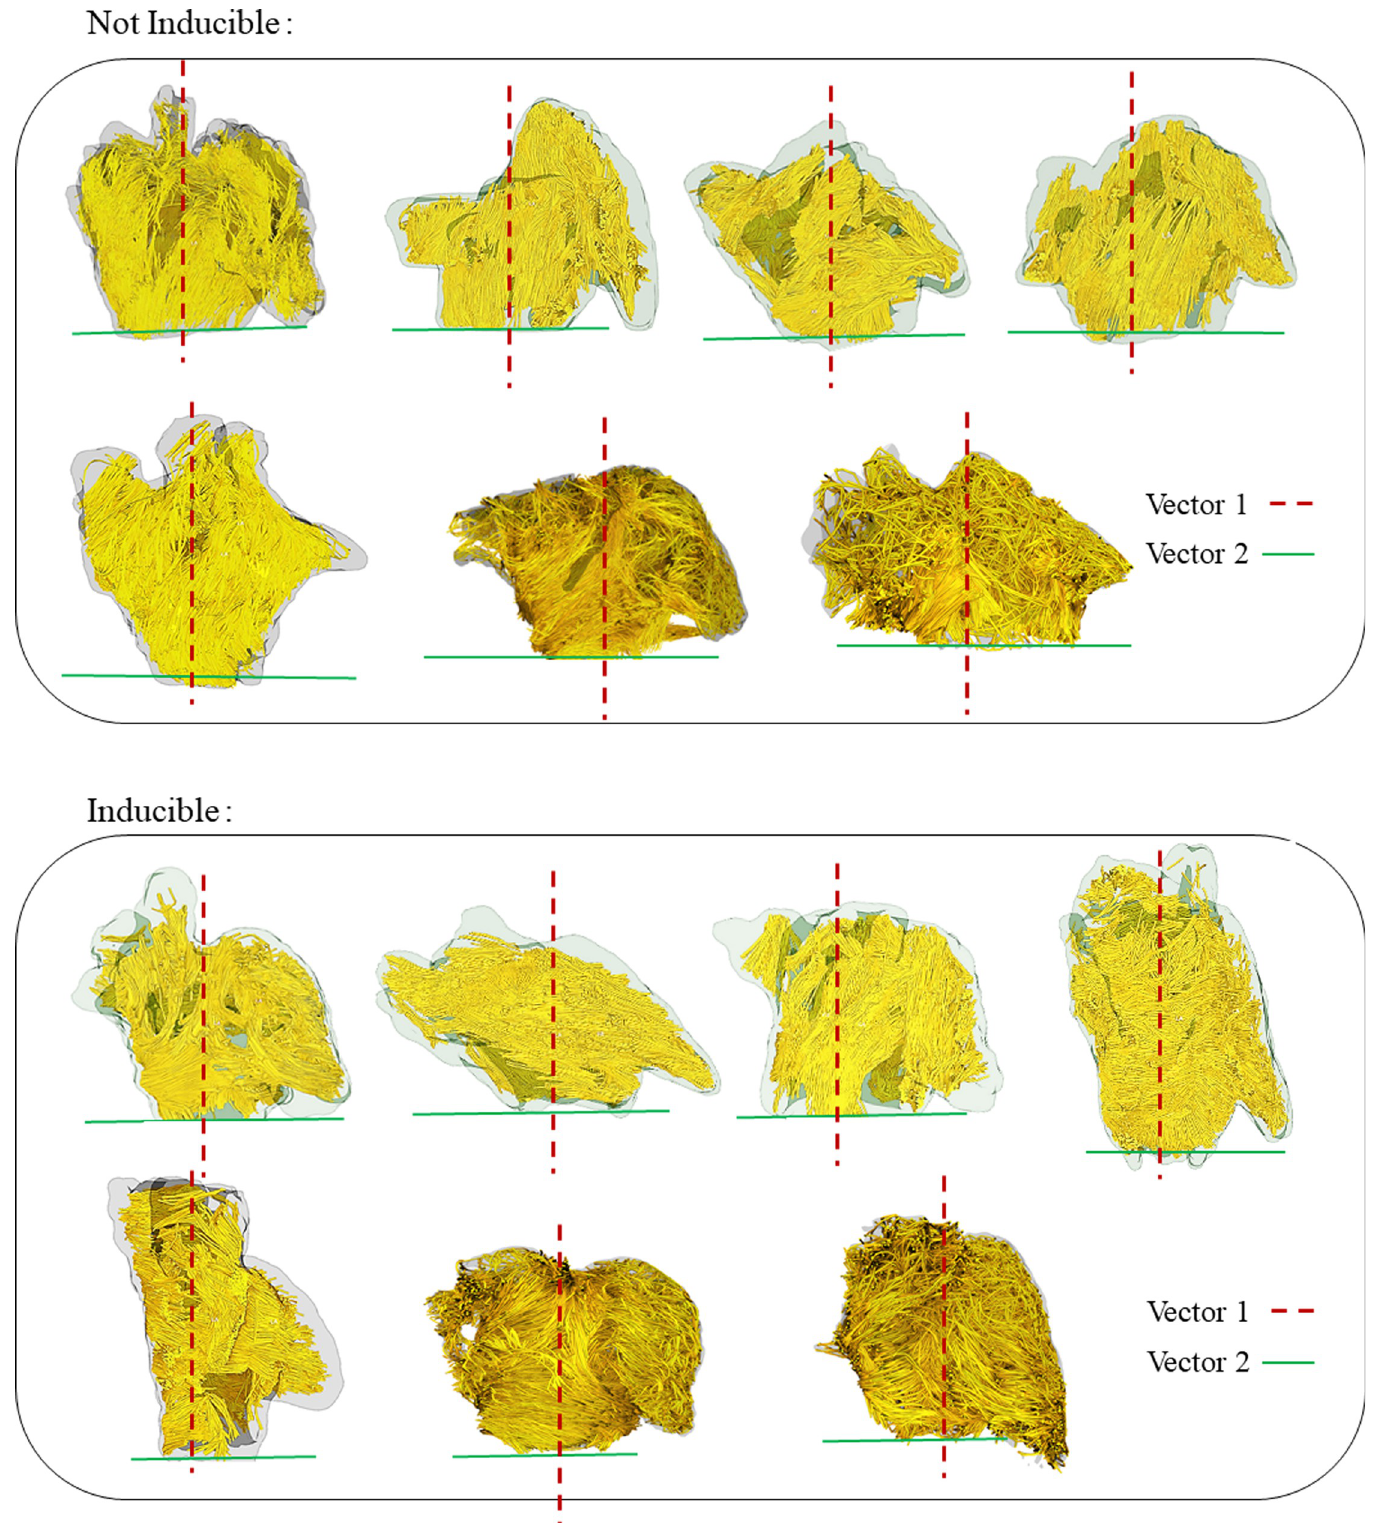
Fig 4. Anterior views of 3D fiber orientations in all scanned goats categorized based on their AF inducibility. The reference vector 1 is shown in red and reference vector 2 is shown in green.